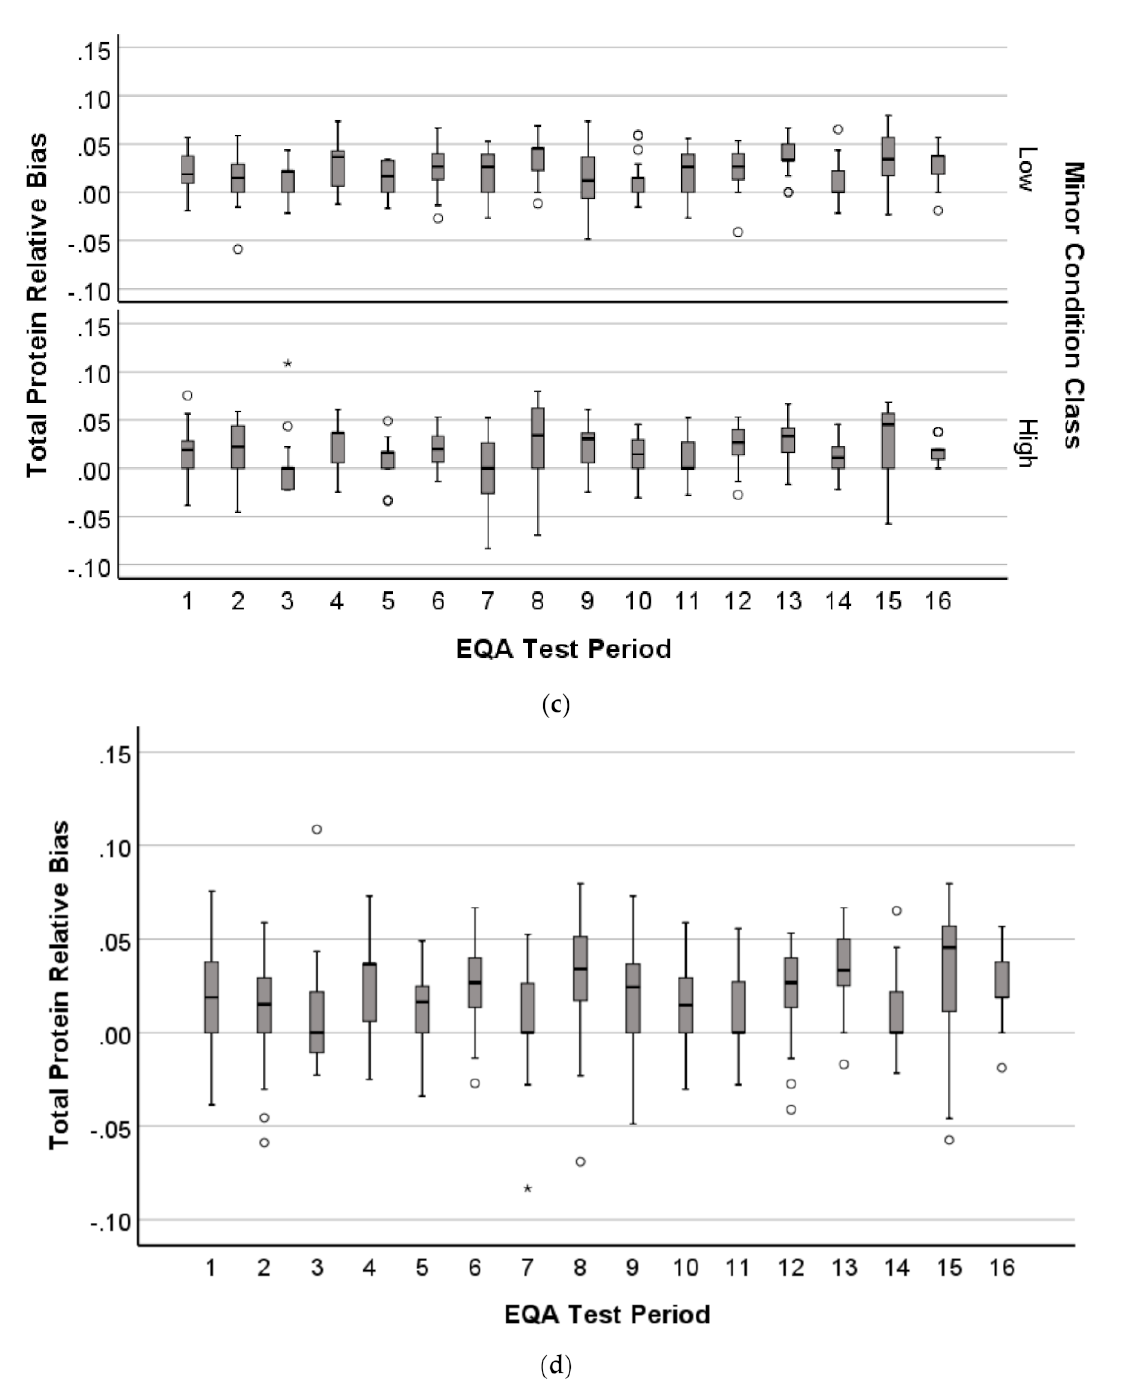
Figure 7. EQA relative deviation (bias) variation over a period of 16 EQA challenges for ( a , b )-glutamyl transferase (GGT) and ( c , d ) Total Protein (TP), represented by boxplots (median ± interquartile ranges). Both GGT ( a ) and TP ( c ) were separated by NATA Minor Classes for variation